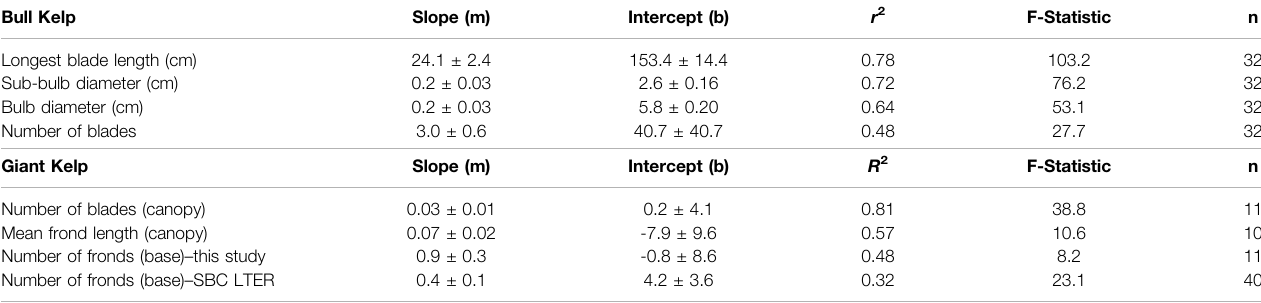
TABLE 3 | Linear regression statistics for the different morphometric measurements for estimates of wet weight. Bull Kelp Slope (m) Longest blade length (cm)